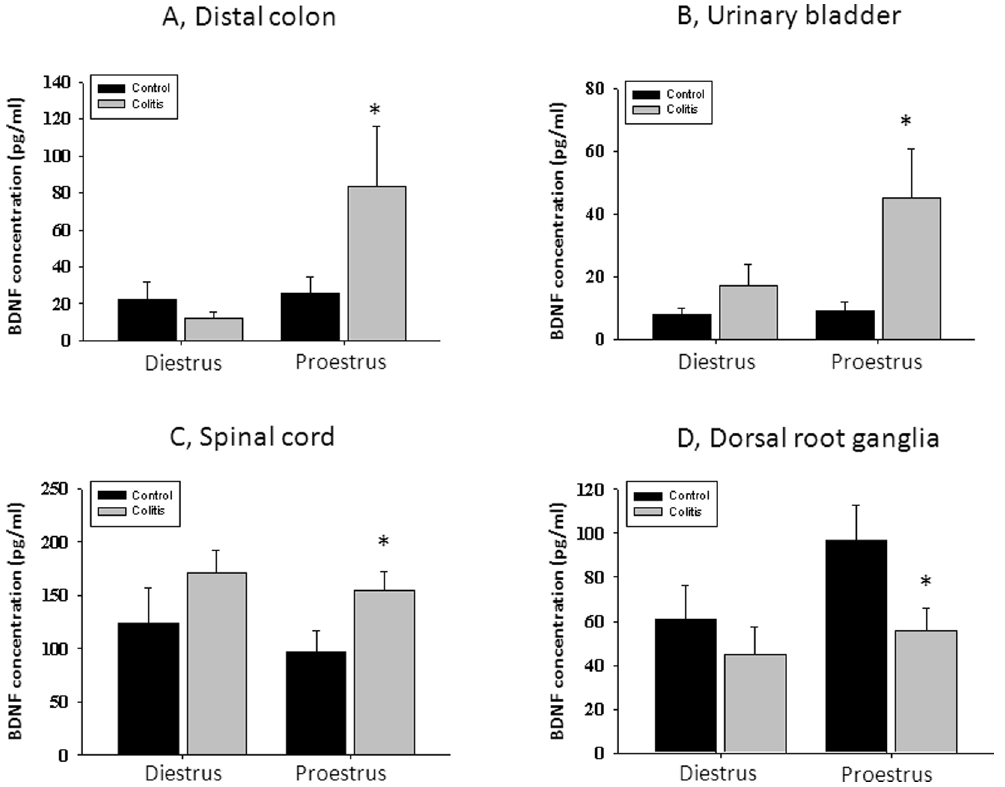
Figure 4. Protein levels of BDNF are modulated by ovarian hormones during active colitis. A, BDNF content in the distal colon during low (diestrus) and high (proestrus) estrogen. B, Concentration of BDNF in the urinary bladder during diestrus and proestrus phases. C, Experimentally induced colitis significantly up-regulated BDNF content in the lumbosacral spinal cord during proestrus phase. D, BDNF fluctuations within the estrous cycle in L6-S2 sensory ganglia innervating the pelvic organs. * - p # 0.05 to respective control